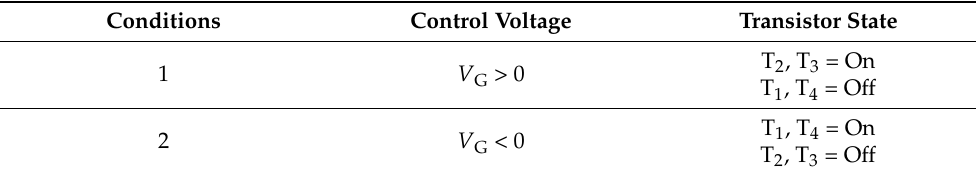
Table 1. Conditions w.r.t the control voltage, V G